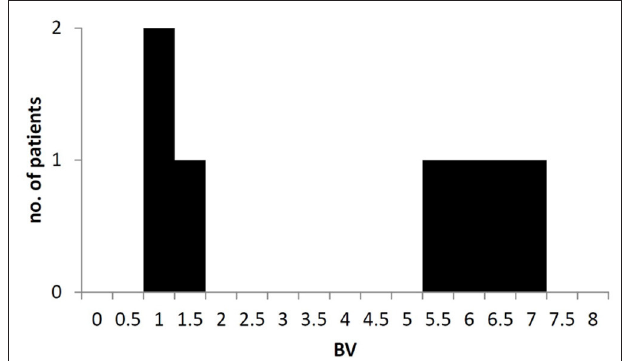
FIGURE 8 | Bimodal distribution of Brix Value in aspirates of gastric content after fasting. Brix values > 3 most likely reflecting the presence of remnants from nutrition formula or other ingested solutes within the stomach in some